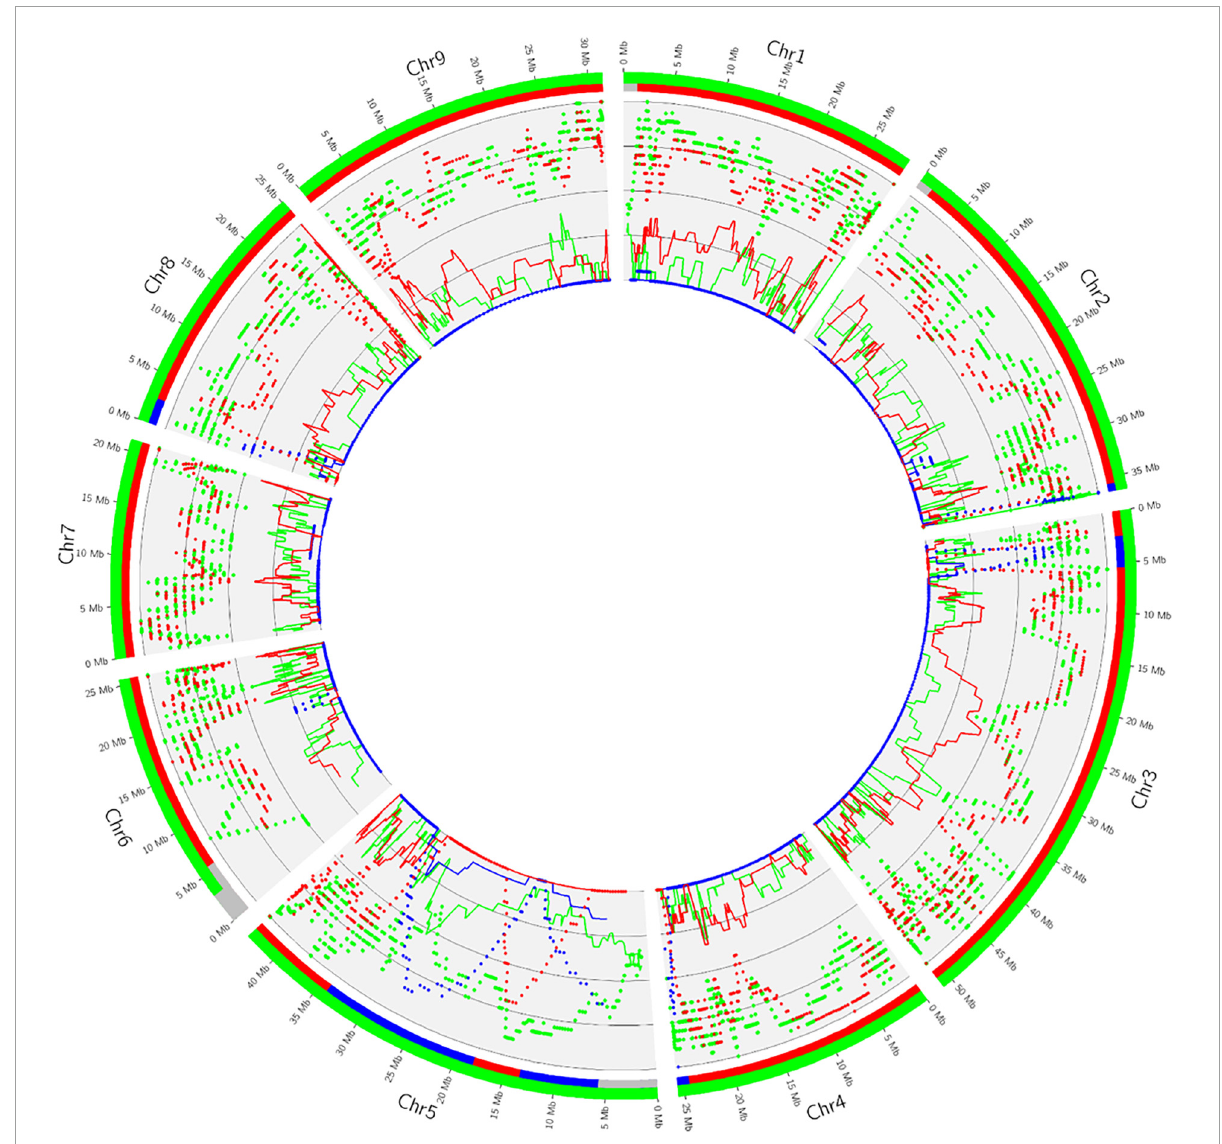
FIGURE7 Distribution of heterozygosity (dashes) and homozygosity (line) of the ancestral alleles of E. glauca (green), C. reticulata (red), and C. maxima (blue) along the genome of the supposed E. glauca × C. × sinensis hybrid and phylogenomic karyotype inference (external ribbons with the same color code). Gray corresponds to undetermined